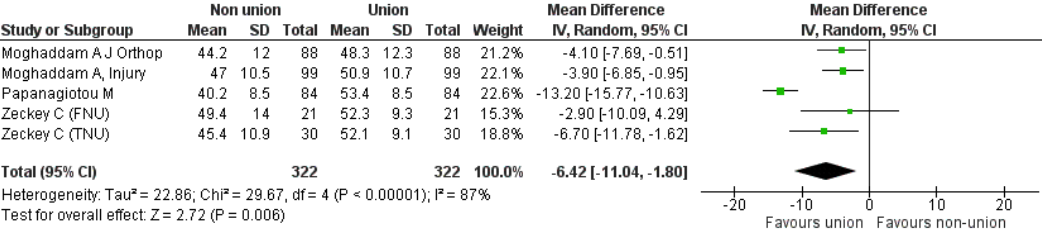
Figure 6. SF-12 MCS pooled analysis between nonunion and union.